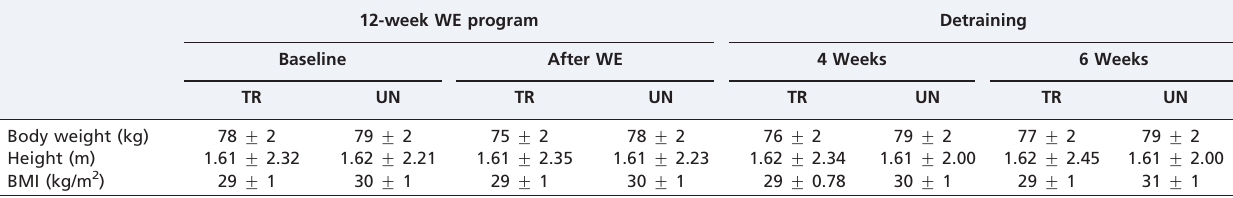
Table 1 - Changes of biometric parameters after training and detraining.